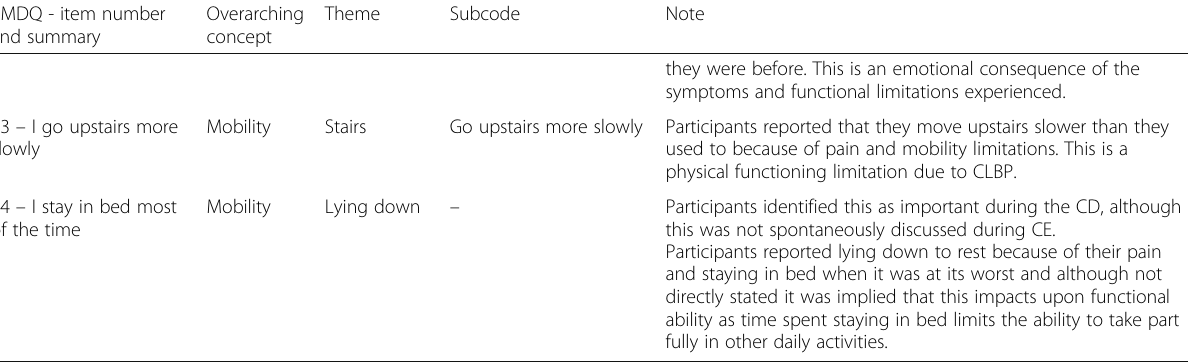
Table 3 Mapping the themes identified in coding to the RMDQ items (Continued) RMDQ - item number and